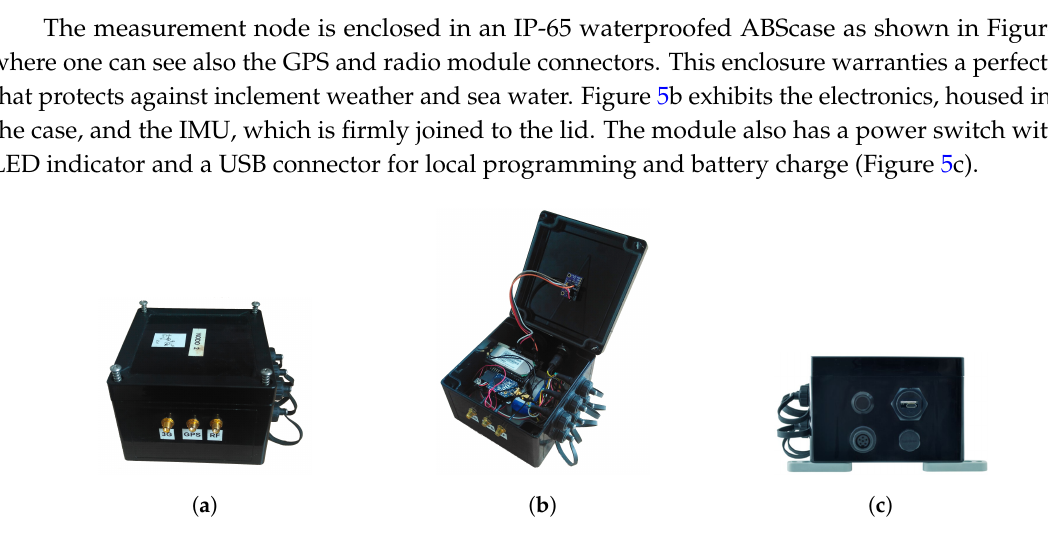
Figure 5. Measurement node: ( a ) enclosure with RF connectors; ( b ) electronics and IMU (under the lid); ( c ) switch button and USB